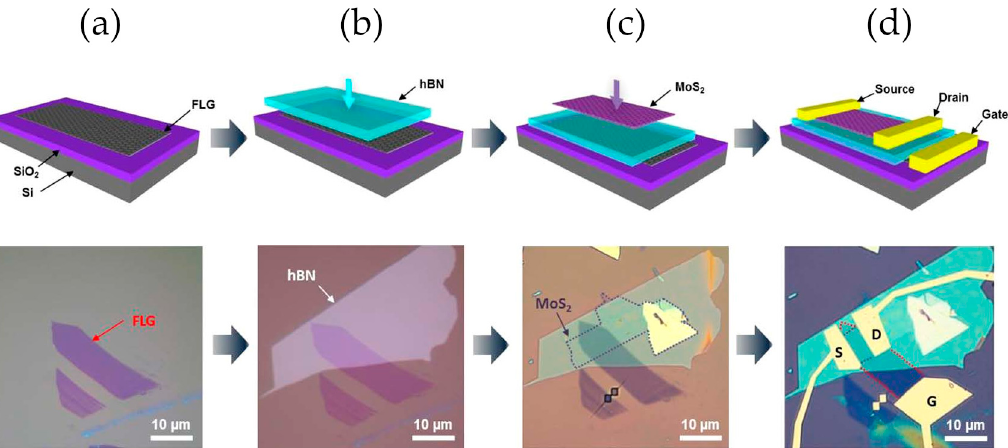
Figure 3. Schematic and optical images of the fabrication process of a graphene/hBN/MoS 2 FET. ( a ) Deposition of the few layers of graphene film. ( b ) Deposition of the hBN monolayer. ( c ) Deposition of the MoS 2 monolayer. ( d ) Fabrication of the metallic Au contacts. Reprinted (adapted) with permission from Ref. [78]. Copyright (2013) American Chemical Society.